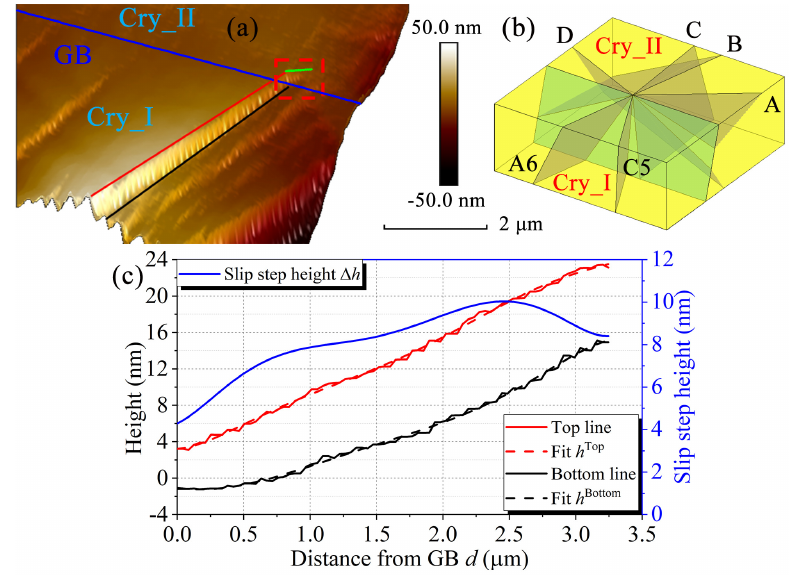
Figure 6. ( a ) ex-situ AFM topographic measurement for the α -Brass sample. The transmission phenomenon and/or dislocation absorption at GB are surrounded by the frame with red dashed lines. The green line indicates the direction of slip transmission. By comparison of this direction with the schematic presentation of the four slip planes in the crystal II ( b ), it can be assumed that the transmission phenomenon occurs in the A slip plane; ( c ) the result of slip step height measurement: red and black solid lines indicate the measured height of the top line and the bottom line of the step, respectively. The dash lines with corresponding color indicate the fitted results by the polynomial method with the correlation coefficient R 2 = 0.9982 for the top line and R 2 = 0.9973 for the bottom line. The blue line indicates the relative height of the slip step calculated as the difference of the fitted heights.